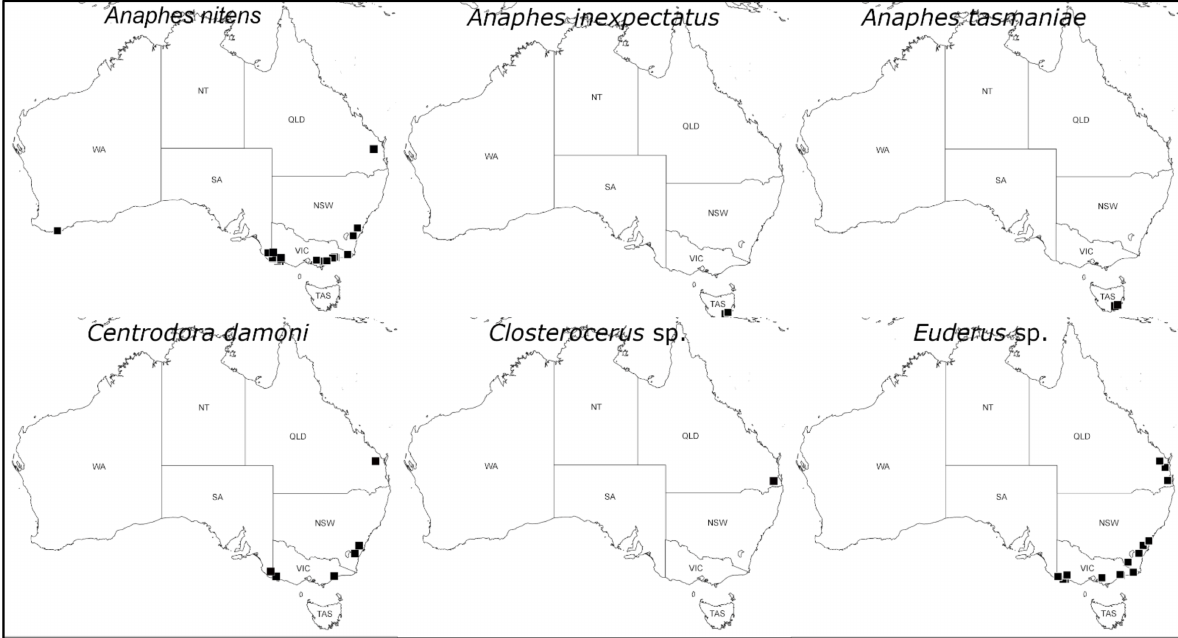
Figure 5. Geographical distribution of Gonipterus egg parasitoid species, Anaphes nitens , Anaphes inexpectatus , Anaphes tasmaniae , Centrodora damoni , Closterocerus sp. and Euderus sp. in south-eastern